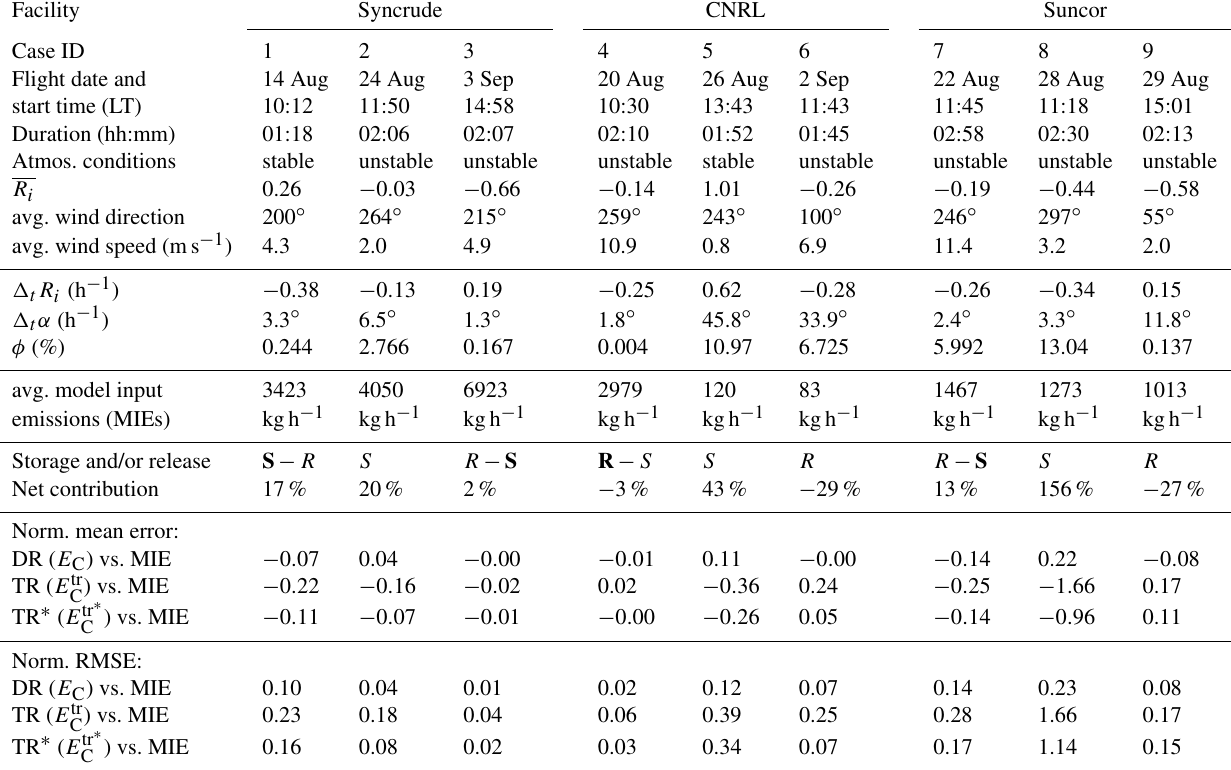
Table 3. A summary of the meteorological conditions and source emission scenarios by the three oil sands facilities for the period of the nine JOSM 2013 box flight cases in our GEM-MACH model simulations. Flight date-time and duration is provided for each case, LT stands for local time (UT − 6h). The flight time average R i , wind speed and direction at plume height are shown. The three forecast parameters are also provided: (cid:49) t R i , (cid:49) t α and φ . DR, TR and TR ∗ method estimates are compared to model input emissions (MIEs). Storage ( S ) and/or release ( R ) events, their order of occurrence (for the cases where both were present) and their relative magnitude (the bigger contribution is represented by boldface letters) are given. The flight time average storage rate as a fraction (%) of the total retrieved emission rates are also provided for each case. The performance of the three retrieval methods against MIE, are shown in terms of NM and NRMS